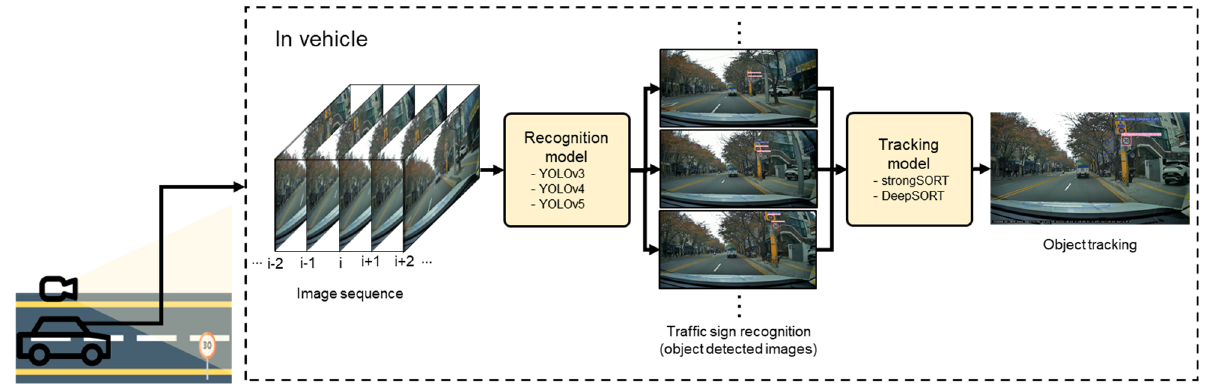
Figure 1. Traffic sign recognition flows in a vehicle using YOLO and tracking models.